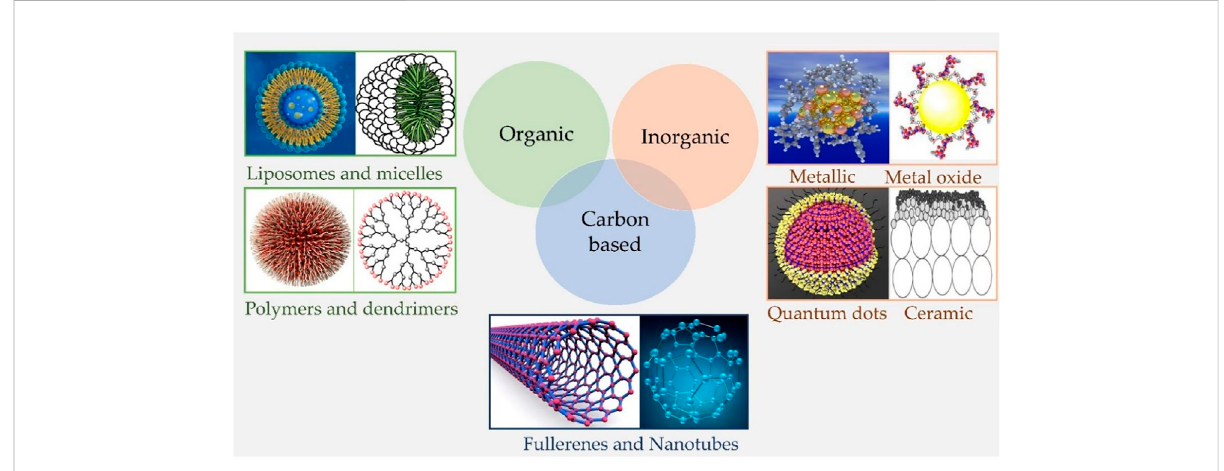
FIGURE 3 Schematicrepresentationofdifferenttypesofnanomaterials.OrganicnanoparticlesincludingLiposomes,micelles,dendrimers,andpolymeric nanocarriers; Inorganic nanoparticles involve metallic, metal oxide, ceramic nanoparticles, and quantum dots; and Carbon-based nanoparticles such as Fullerenes and carbon nanotubes,